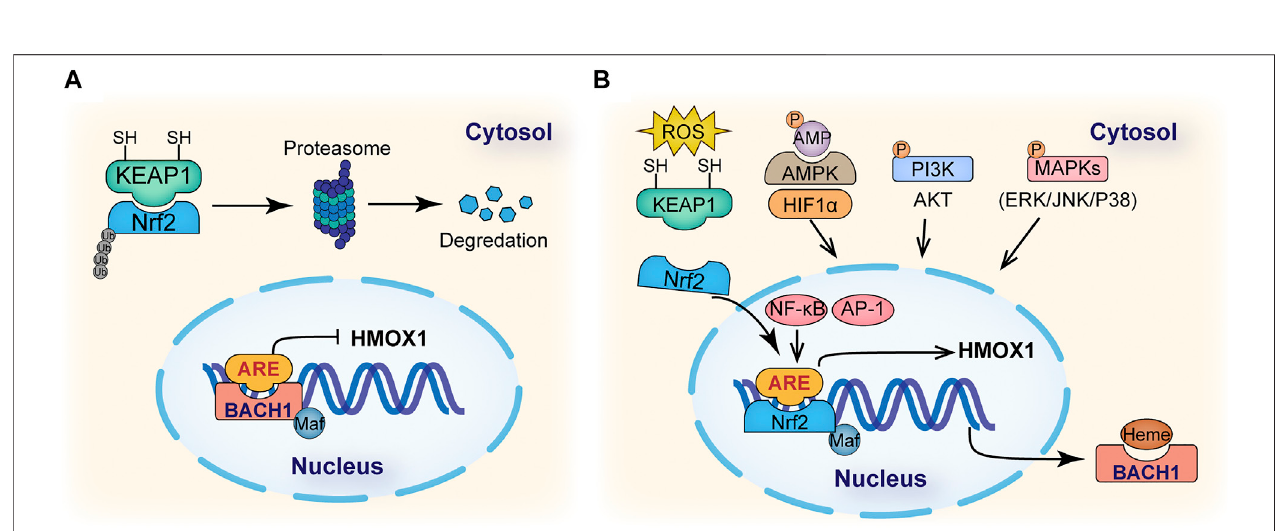
FIGURE 2 | Mechanisms of HO-1 regulation. (A) Under basal conditions, nuclear factor erythroid 2- related factor 2 (NRF2) in cell cytosol binds to Kelch-like ECH- associatedprotein1(KEAP1),whichpromotestheubiquitinationanddegradationofNRF2inproteasomes.Inthenucleus,BACH1isboundtotheAREregionin HMOX1 gene promoter and represses its transcription. (B) Under stress, binding of heme molecules to BACH1 promotes its dissociation from the small Maf protein and ARE motif in the HMOX1 gene promoter. ROS induces changes in KEAP1 cysteine residues, promoting the nucleus translocation of NRF2 to bind the ARE motif in HMOX1 gene promoting its expression. Signaling cascades, such as AMP- activated protein kinase (AMPK), phosphatidylinositol 3-kinase (PI3K), mitogen-activated proteinkinases(MAPKs),andtranscriptionfactors,suchashypoxia-induciblefactor1 α (HIF1 α ),AP-1andNF- κ B,havealsobeenreportedtobeinvolvedintheregulation of HO-1 expression.